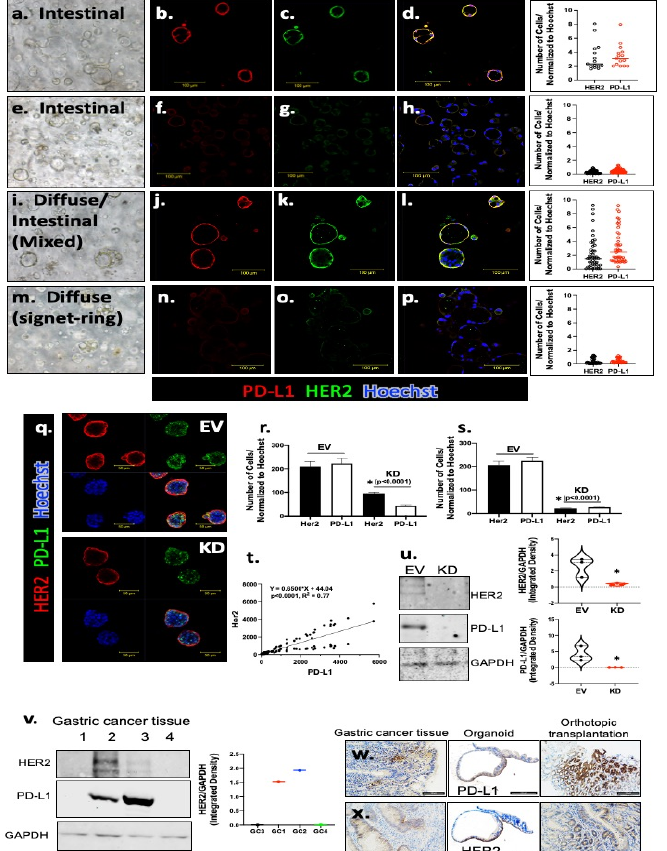
Figure 6. HER2 expression is significantly correlated with PD-L1 expression in gastric cancer tissues. Brightfield images showing morphological differences among huTGOs derived from intestinal ( a , e ) and diffuse ( i , m ) subtypes of gastric cancer tissues. Immunofluorescence staining of these organoids showed a high expression of ( b – d , j – l ) HER2 (red) and PD-L1 (green) in two of the organoid lines while others showed a negative expression ( f – h , n – p ) for both. Western blot ( v ) analysis of gastric cancer tissues showed a similar expression pattern. ( q ) shRNA knockdown of HER2 showed a downregulation of PD-L1 expression which was confirmed by ( u ) Western blot analysis and quan- tification. ( r , s ) Quantification of HER2 and PD-L1 positive cells showed a significant reduction in the expression of both genes after HER2 shRNA knockdown; * p <0.0001. ( t ) Linear regression anal- ysis showing a positive correlation of HER2 and PD-L1; Immunohistochemistry of PD-L1 ( w ) and HER2 ( x ) retained high expression levels among gastric cancer tissues, tissue-derived organoids and orthotopically transplanted organoids . Scale bar = 100 μ m and 50 μ m